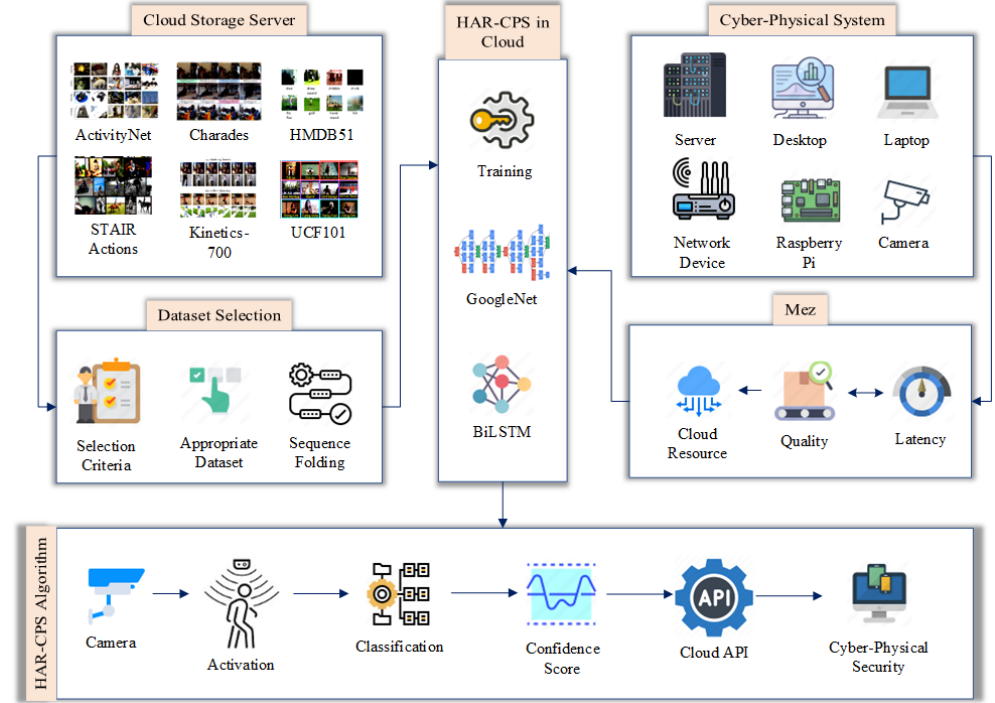
Figure 1. The overview of the proposed methodology.